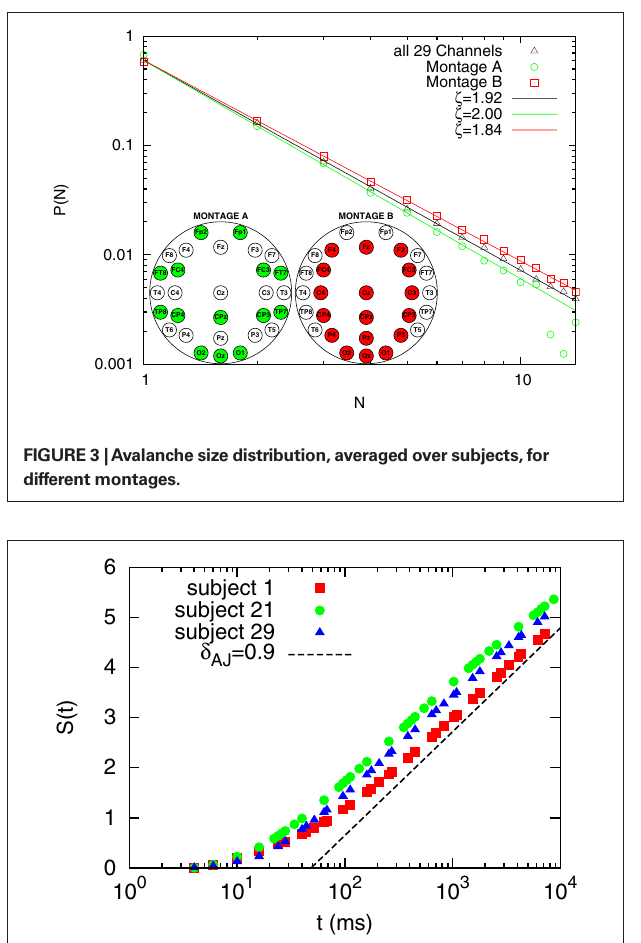
FiGuRE 4 | Diffusion entropy analysis for subjects 1, 21, and 29.